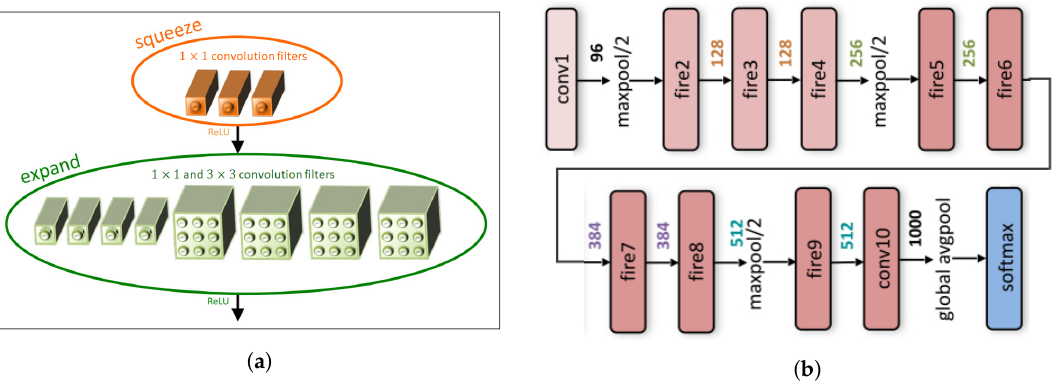
Figure 2. ( a ) Fire module in SqueezeNet; ( b ) SqueezeNet architecture (Figure from